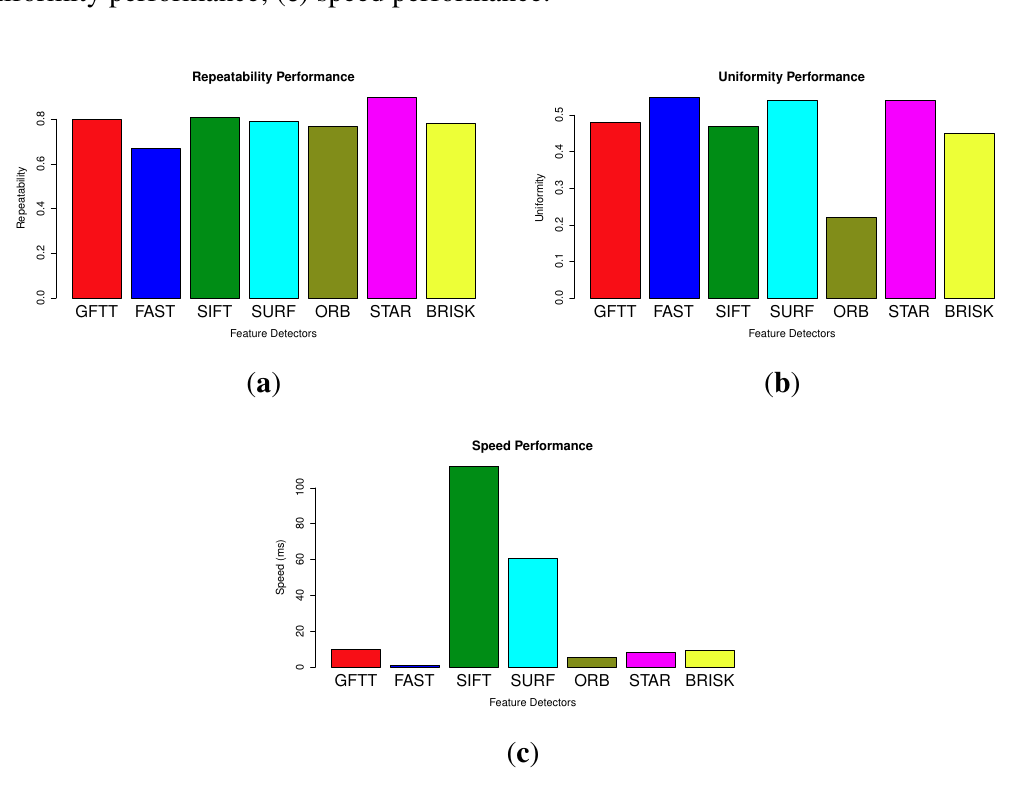
Performances of the feature detectors. ( a ) Repeatability performance; ( b ) uniformity performance; ( c ) speed